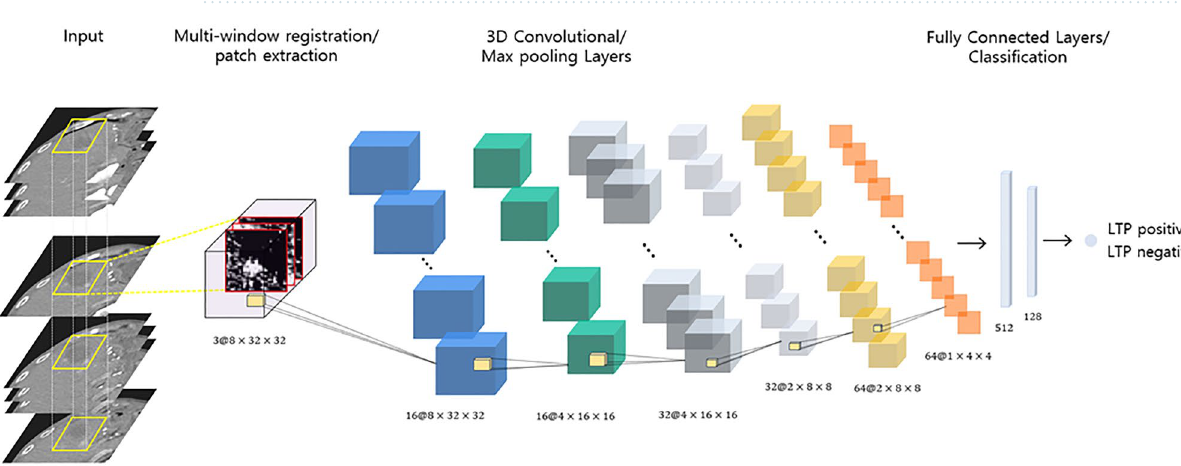
Figure 6. Illustration of the proposed 3D-CNN architecture. The network contains three convolutional layers, two max-pooling layers, and two fully connected layers. The number below each layer represents the feature map size after